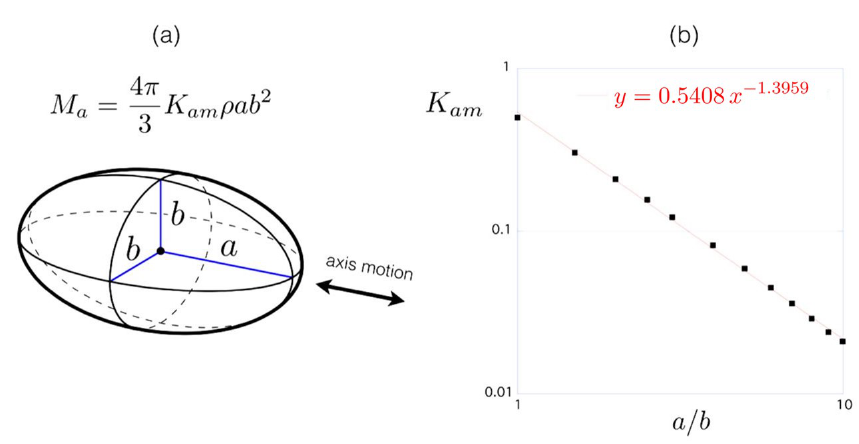
Figure 7. ( a ) Presentation of the ellipsoid. ( b ) Added mass factor K am as a function of the aspect ratio a / b